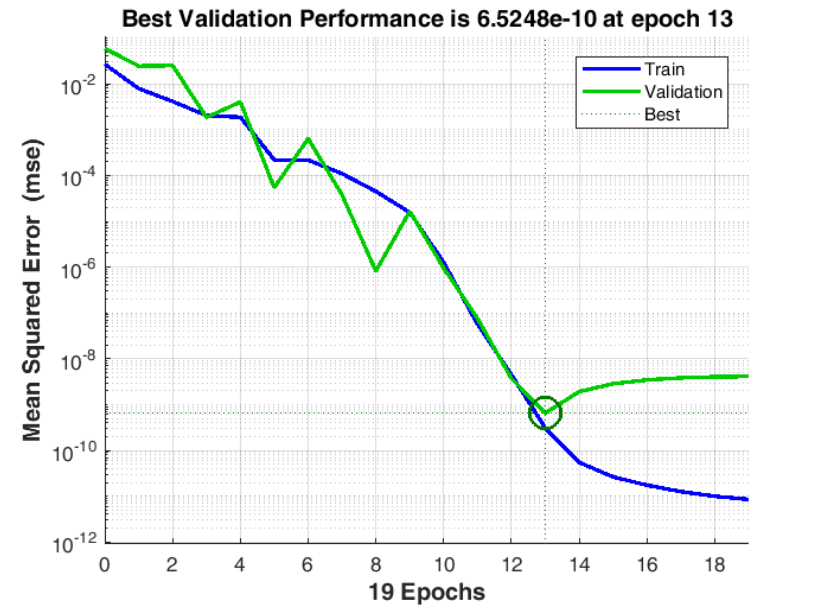
Figure 2. Best PHANN performance avoiding